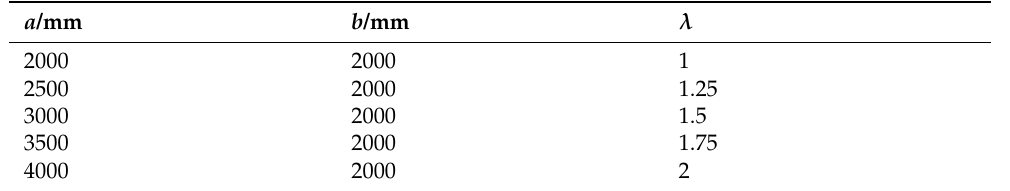
Table 4. Dimensions of the sandwich panel with different aspect ratios.